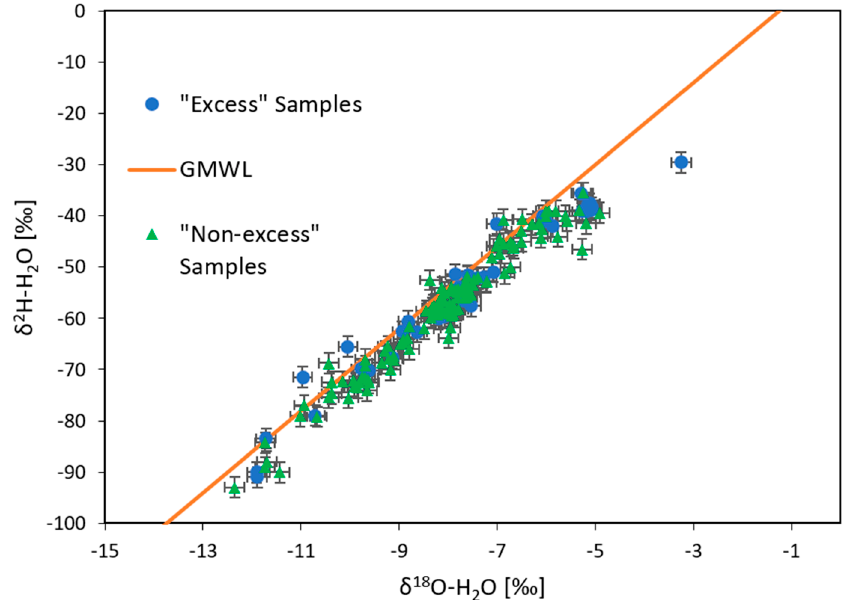
Figure 3. Results for stable isotopes of water for samples categorized as ‘excess’ and ‘nonexcess’. The red line represents the Global Meteoric Water Line, which follows the equation δ 2 H-H 2 O = 8* δ 18 O-H 2 O + 10.